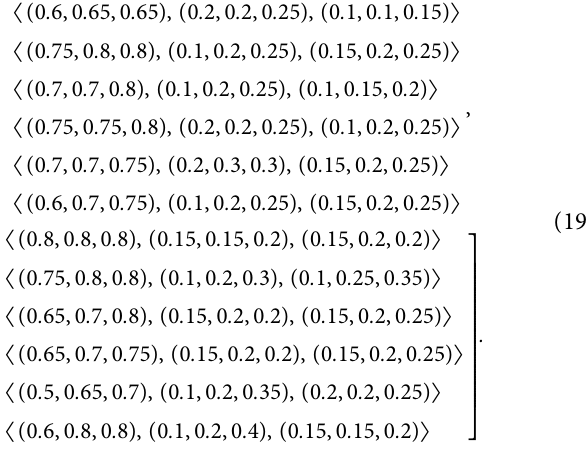
Step 2: Using equations (2)–(10) corresponding to the confdence levels of 90%, 95%, and 99% with the � 1.645, 1.96, and 2.576 for δ � specifed values s δ /2